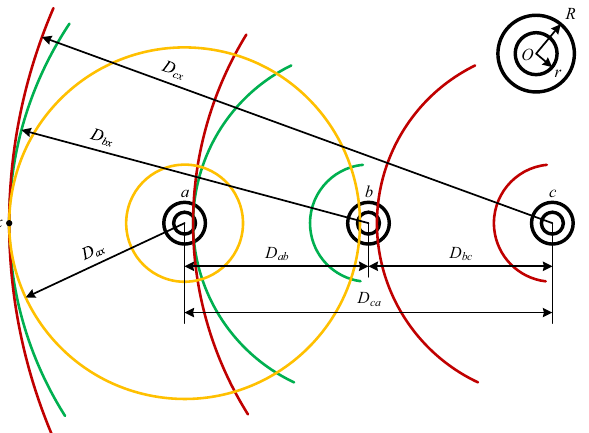
Figure 3. The distribution of magnetic fields of three-phase tubular conductors in a parallel